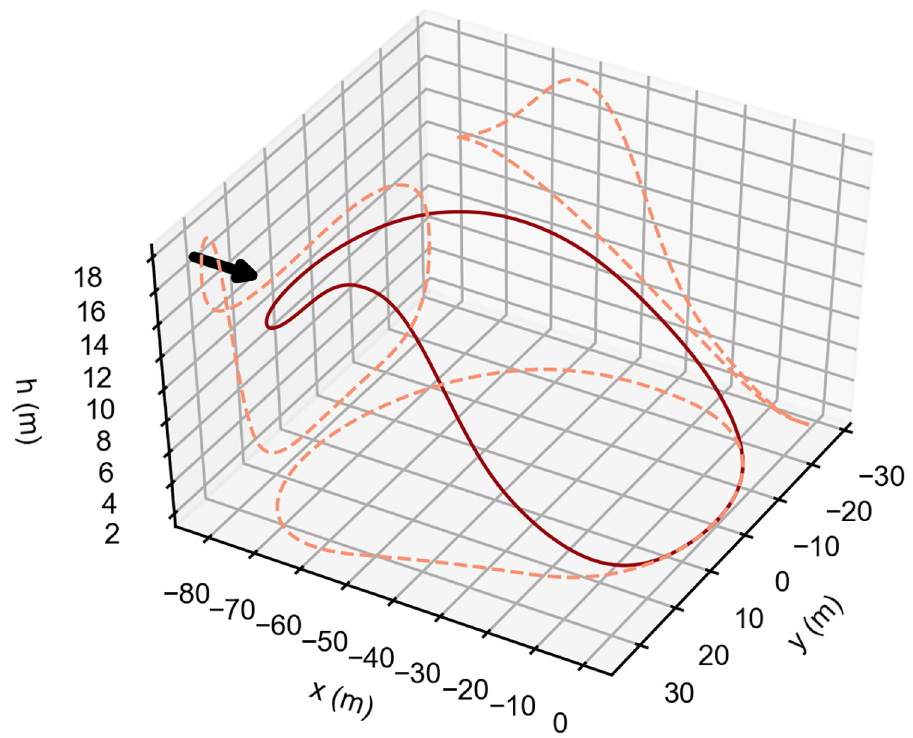
Fig 14. Possible surveillance trajectory. Optimal single-loop, energy-neutral trajectory that maximizes the time aloft. The arrow indicates the wind direction. The vehicle travels in the clockwise direction.